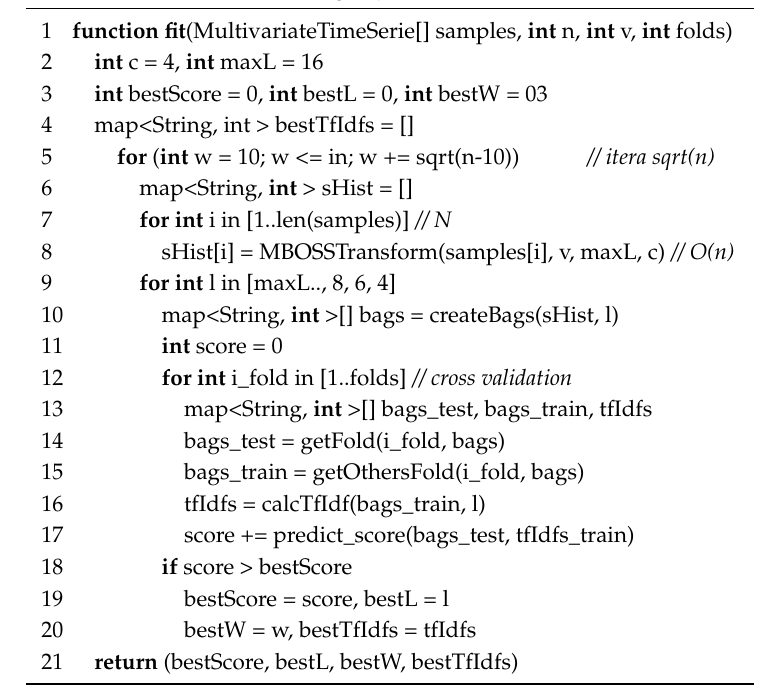
Algorithm 3. Fit MBOSS using 10-fold cross-validation